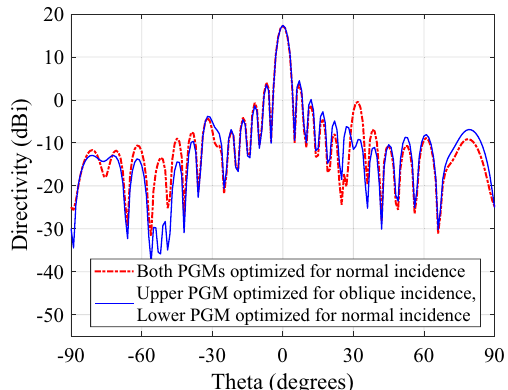
Figure 7. Comparison between the broadside radiation pattern predicted using CST array calculator for a pair of conventionally optimized PGMs for normal incidence and a pair of PGMs where the upper PGM is optimized for oblique incidence while lower PGM is optimized for normal incidence. The PGMs pairs are 0 180 aligned such that ψ 1 ◦ and ψ 1 = ◦ . =